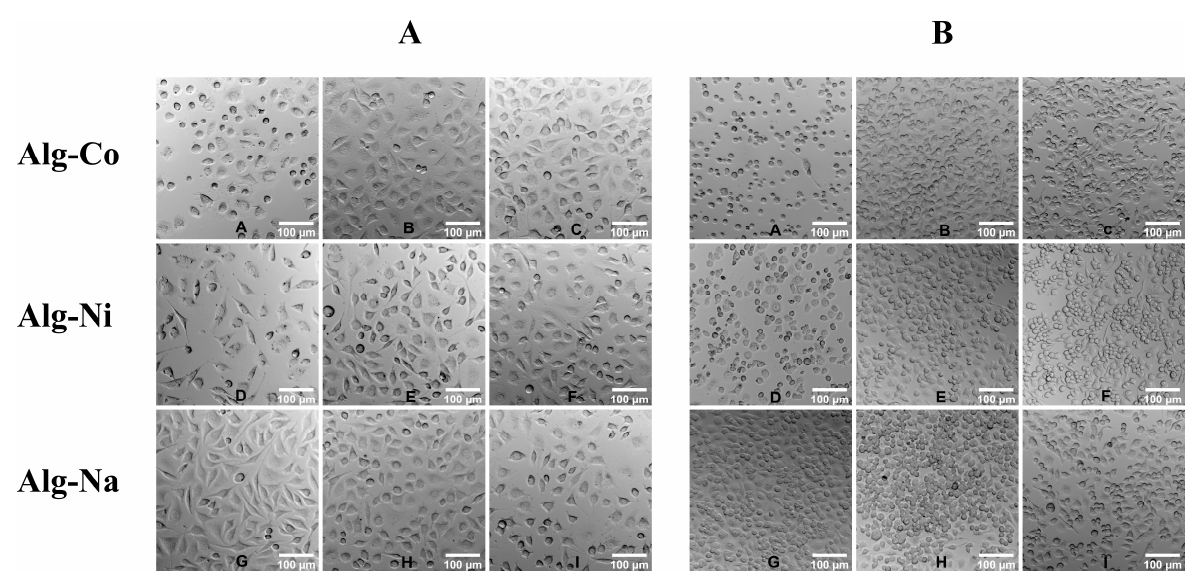
Figure 4. Phase contrast images of L929 ( A ) and RAW264.7 ( B ) cells grown in the presence of Alg-Co (cobalt alginate), Alg-Ni (nickel alginate) and Alg-Na (sodium alginate). Alg-Co—A = 0.05%, B = 0.01%, C = 0.001%; Alg-Ni—D = 0.05%, E = 0.01%, F = 0.001%; Alg-Na—G = 0.3%, H = 0.075%, I = 0.001.